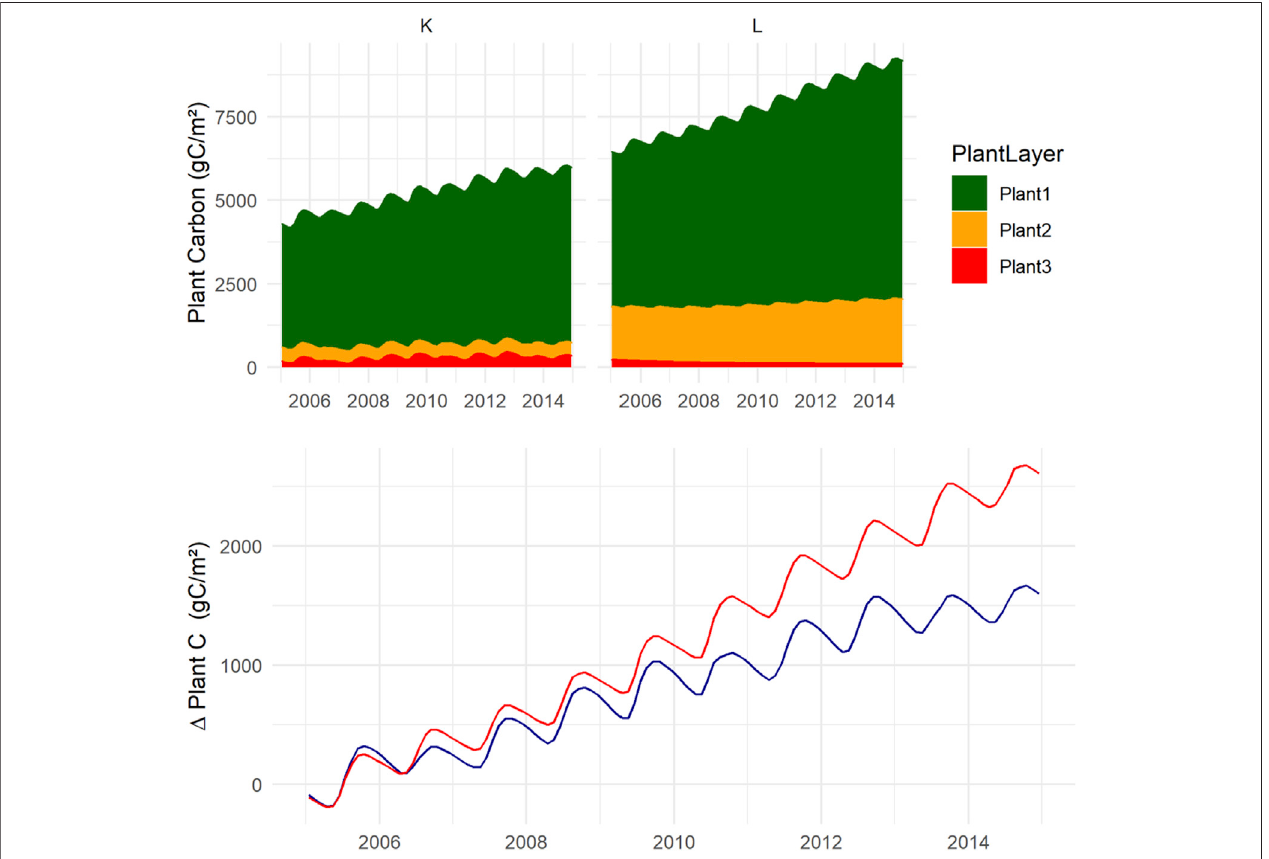
FIGURE7| Plantcarbon accumulation (positivenumbers)over10years,toppanelshowsCaccumulated invegetationanditschangeovertheyears.Vegetation1 (conifer trees) (cid:1) dark green, Vegetation2 (deciduous trees and fi eld layer vascular plants) (cid:1) yellow and Vegetation3 (mosses) (cid:1) red. Bottom panel shows total plant C accumulation of the two scenarios where K (cid:1) blue and L (cid:1) red. Mean of 100 accepted model runs.